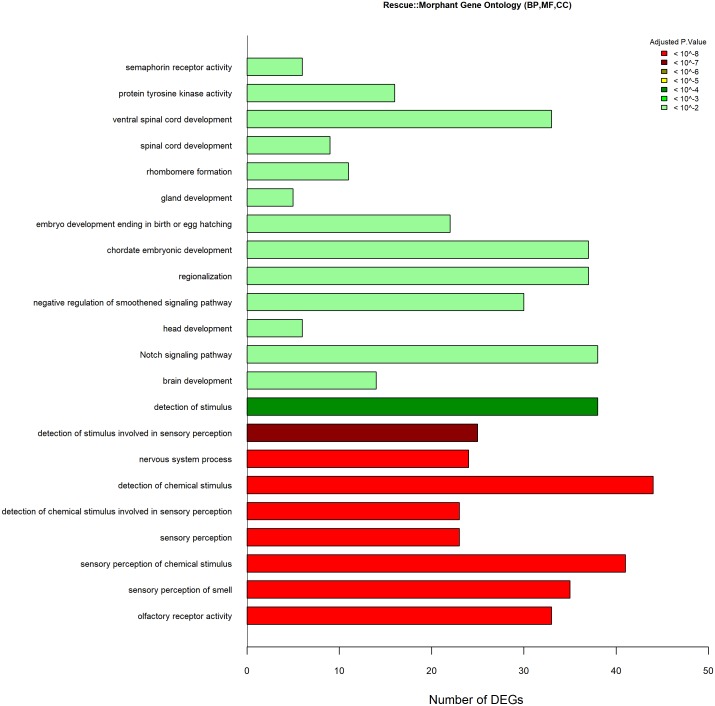
GO Analyses Rescue Vs. knockdown.Gene Ontology enrichment results (P < 0.01) containing n = 22 terms derived from all three categories (biological process, cellular component, and molecular function) in lepa rescue compared to lepa knockdown treatments. Color scale reflects adjusted p.value; the x-axis denotes the number of DEGs that map to each enriched term.